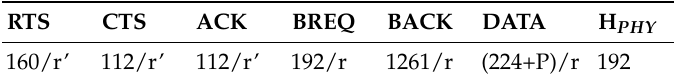
Table 1. Transmission time in µ s.